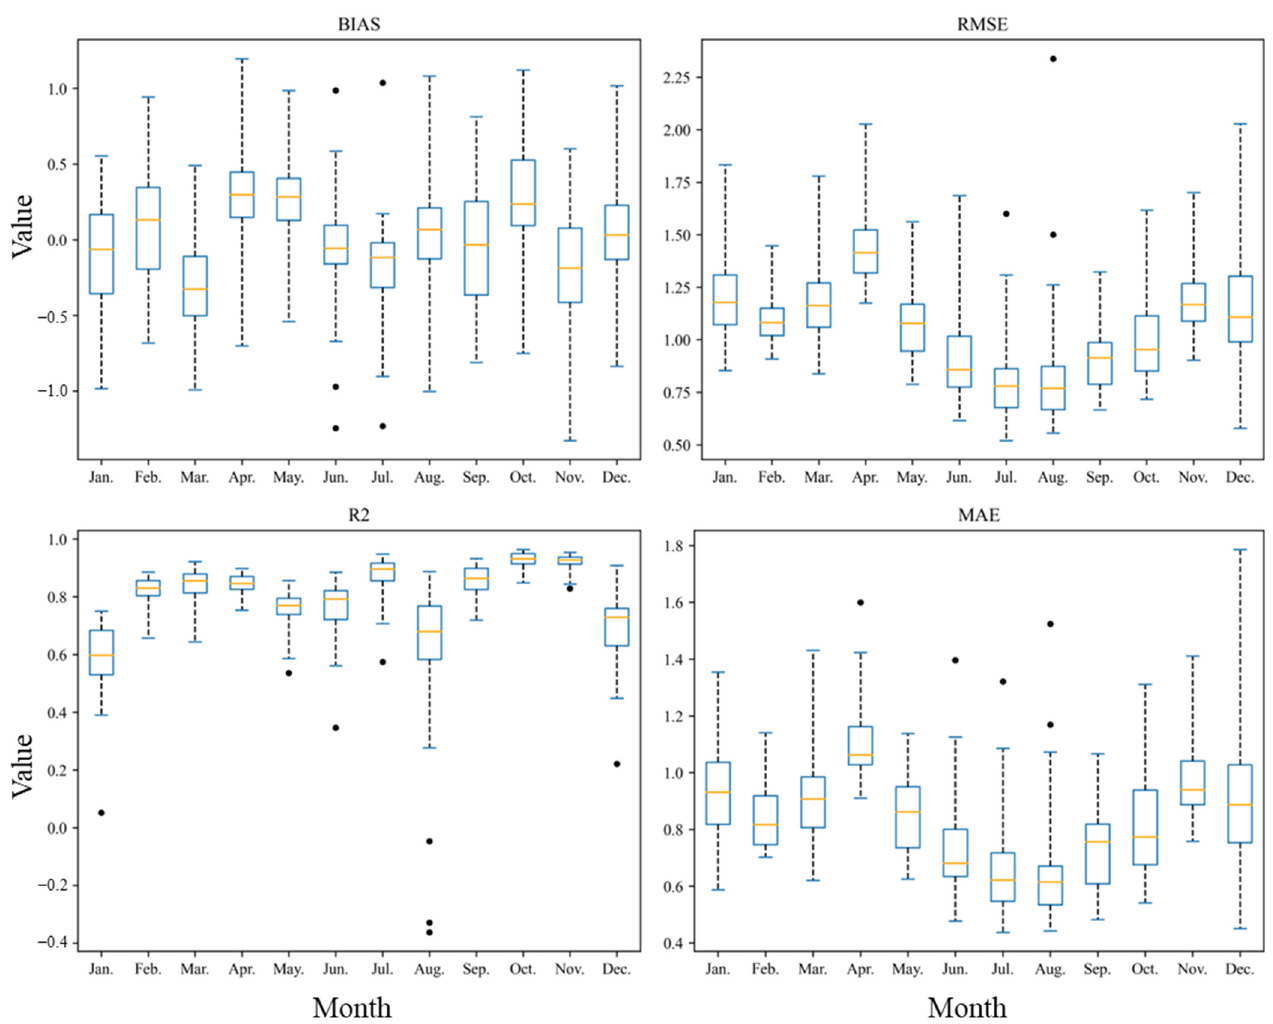
Figure 12. The temporal variations of R 2 , RMSE, MAE and BIAS in each month. The black dots represent outliers.